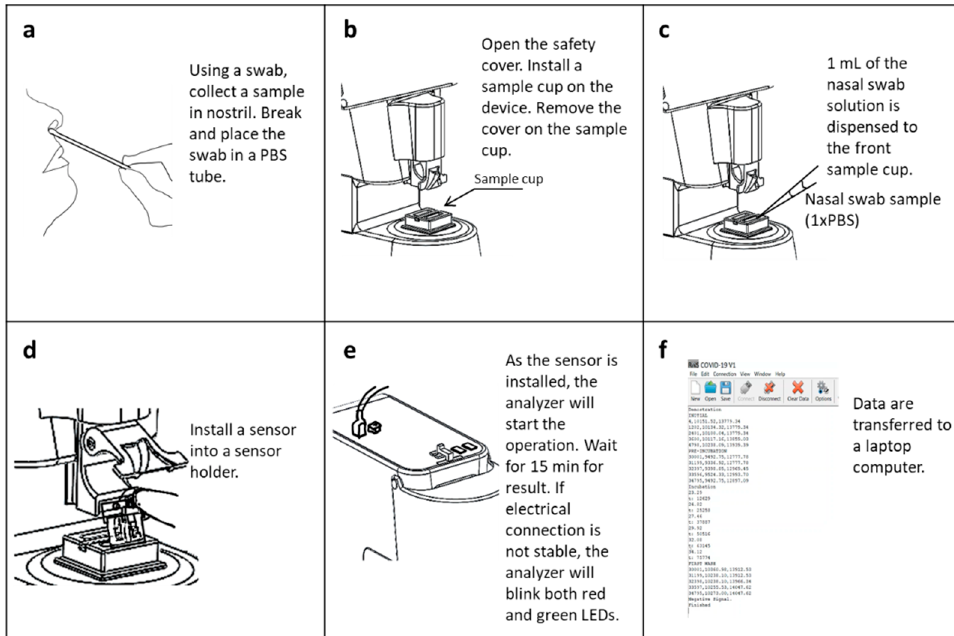
Figure 2. Screening protocol ( a ) Nasal swab sample is collected from nostril. The nasal swab is immersed and eluted in 1xPBS. ( b ) Install a sample cup where 1.1 mL DI water is contained. ( c ) A nasal swab sample of 1 mL is transferred to a sample cup. ( d ) Install a sensor with inspection of electrical connection. ( e ) Press a reset switch to begin detection protocol. ( f ) Data are collected after 15